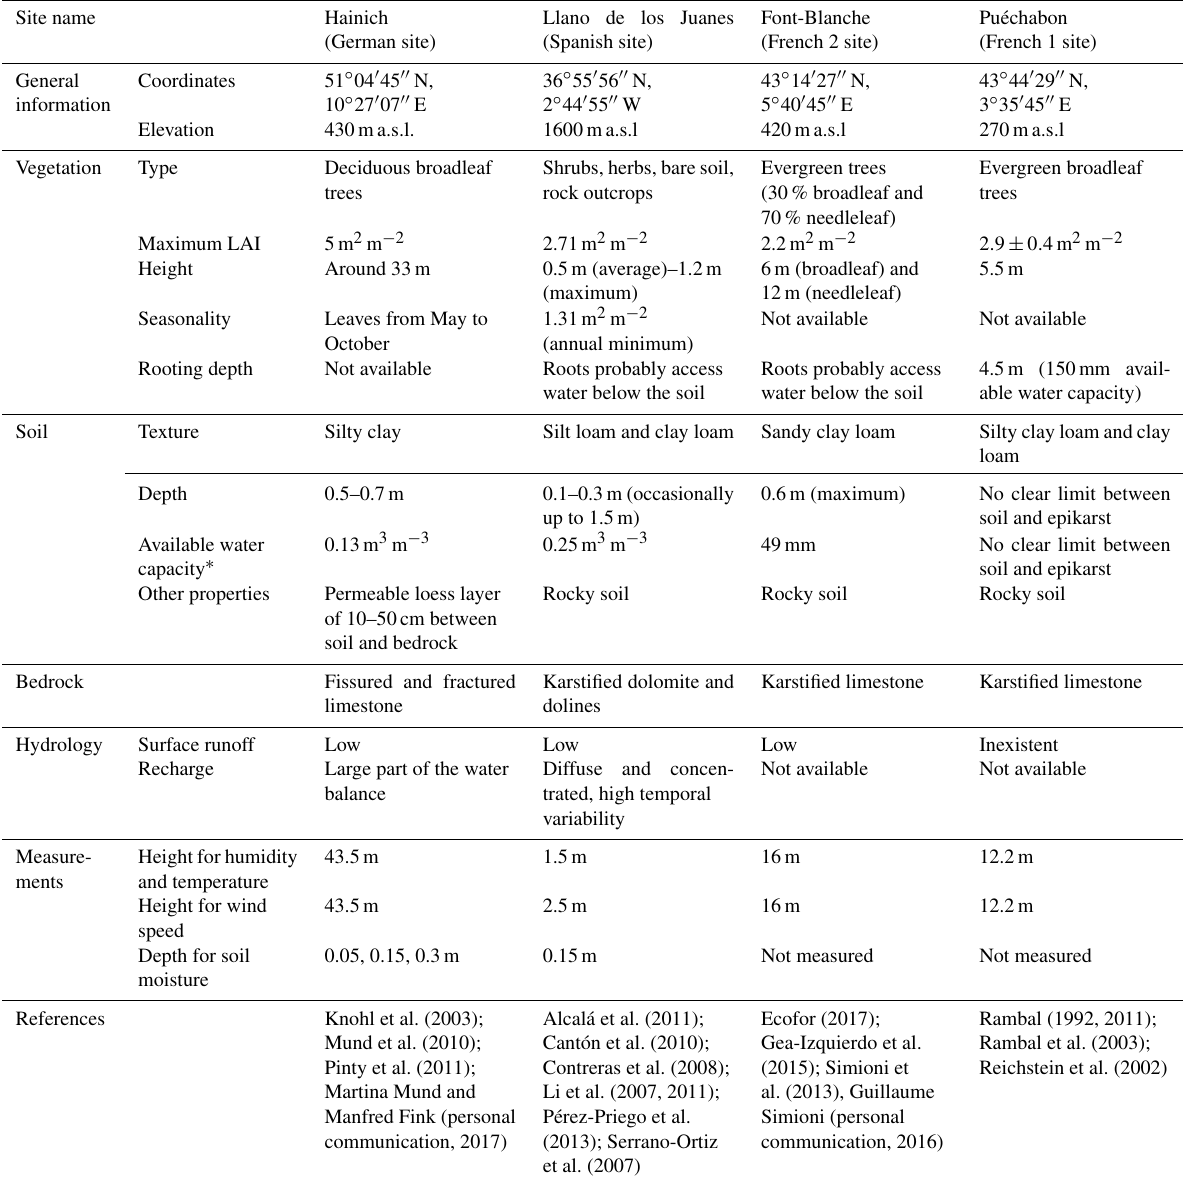
Table B1. Description of the four carbonate rock FLUXNET